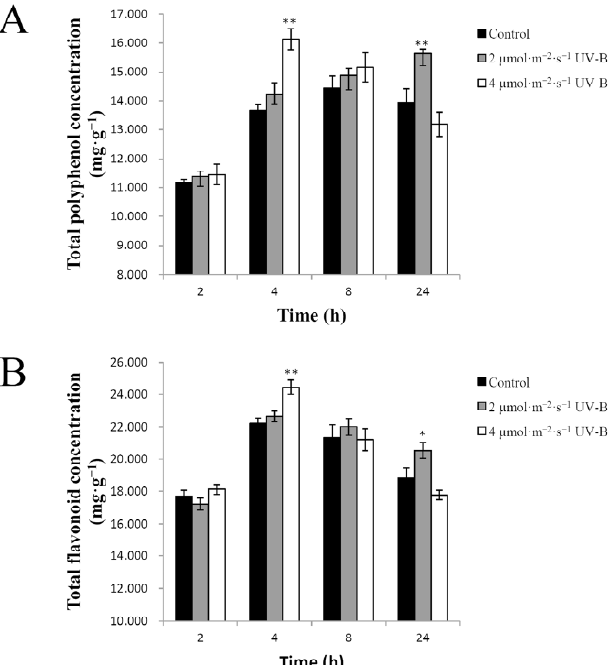
Figure 4. The effect of UV-B radiation on the antioxidant concentrations of pakchoi. ( A ) The total polyphenol concentration of 25-day-old seedlings treated with either 2 µ mol · m − 2 · s − 1 or 4 µ mol · m − 2 · s − 1 of UV-B radiation at 2 h, 4 h, 8 h, or 24 h. ( B ) The total flavonoid concentration of 25-day-old seedlings treated with either 2 µ mol · m − 2 · s − 1 or 4 µ mol · m − 2 · s − 1 of UV-B radiation at 2 h, 4 h, 8 h, or 24 h. The plants untreated with UV-B radiation served as controls. Three independent biological replicate experiments were performed; data points represent the mean ± SE of the three biological replicates. Asterisks indicate a significant difference (* p < 0.05; ** p < 0.01) relative to the corresponding control using Student’s t -test.